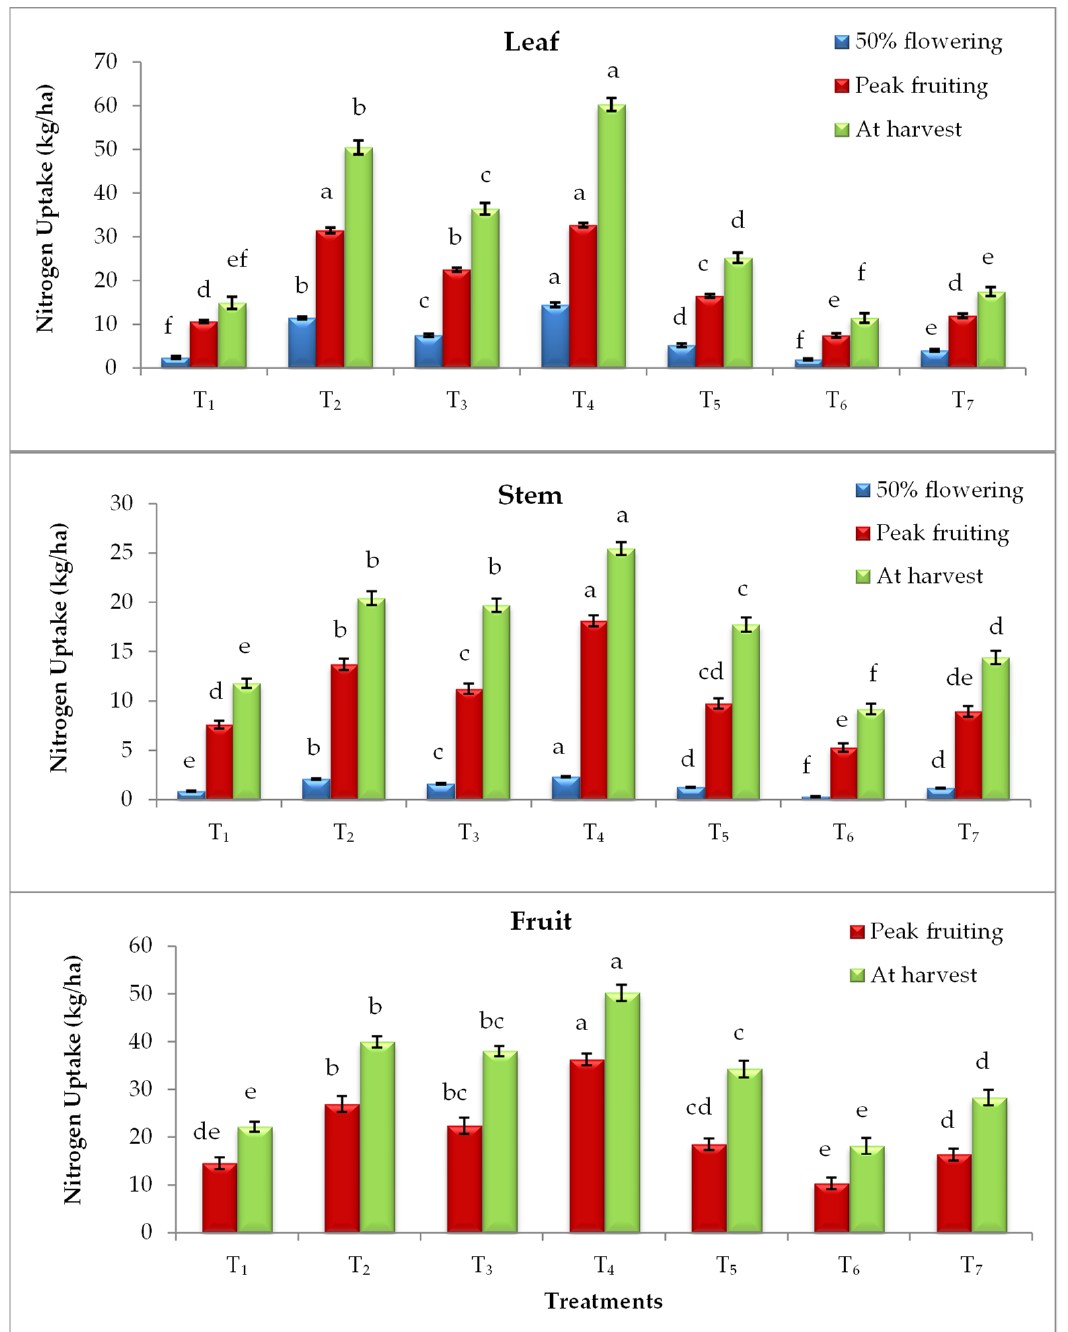
Figure 1 . Nitrogen uptake by leaf, stem and fruit of tomato plants as influenced by elevated CO 2 and temperature at 50% flowering, peak fruiting and at harvest stages ( n = 15). Note: According to DMRT, values with same alphabet(s) do not differ statistically at the 0.05 level; Refer Table 1 for the description of the treatments.